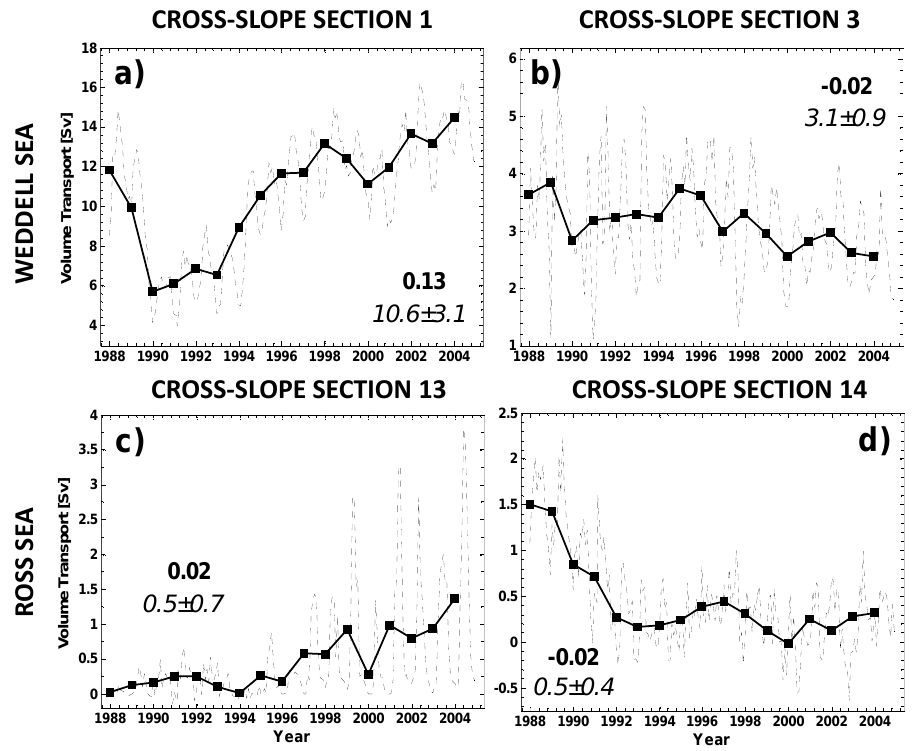
Fig. 8. Monthly (dashed line) and annual (solid line) average of OCCAM-simulated bottom-layer volume transport for ( a and b ) Weddell and ( c and d ) Ross Seas cross-slope sections as indicated. The bold and italic annotations show respectively the decadal linear trend (Sv decade − 1 ) and the average and standard deviation for the entire period.